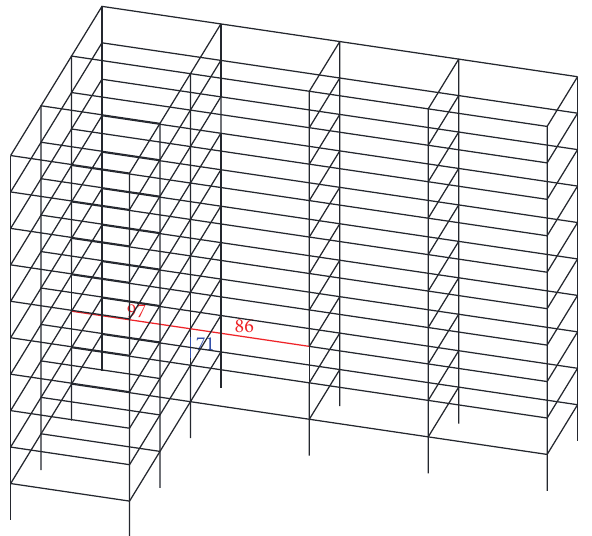
Figure 21: Schematic representation of indicated damaged elements in D1 using incomplete mode shapes.